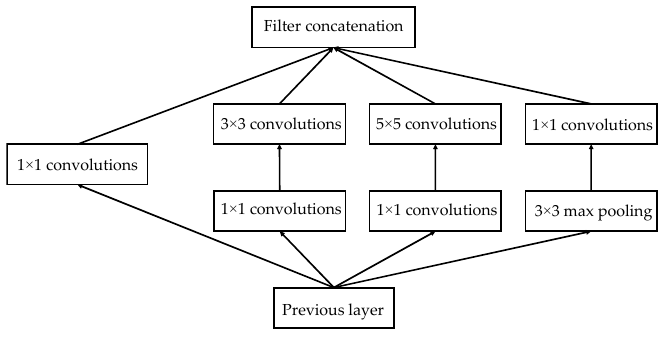
Figure 4. Architecture of the inception.